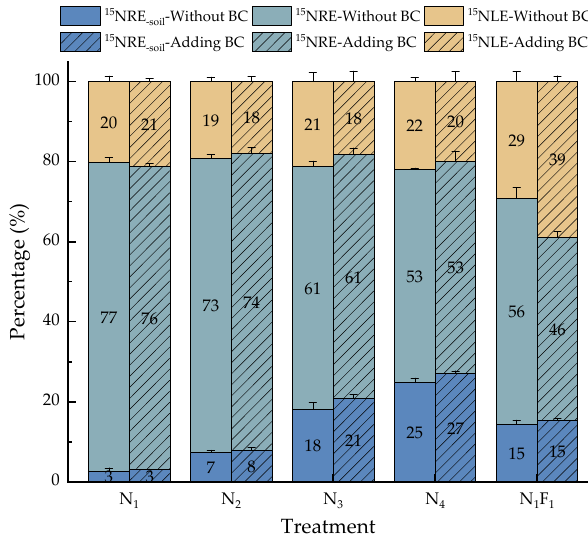
Figure 6. Marking the fate of 15 N fertilizer (%). Note: The figure shows the fate of each treatment mark 15 N after application to the soil, including being lost, taken up by plants, and retained by the soil. Data are mean ± standard error (n = 5). N 0 , N 1 , N 2 , N 3 , and N 4 represent the urea application rate, 0, 100, 200, 300, and 400 kg N ha − 1 , respectively. F 1 represents organic manure of 100 kg N ha − 1 .